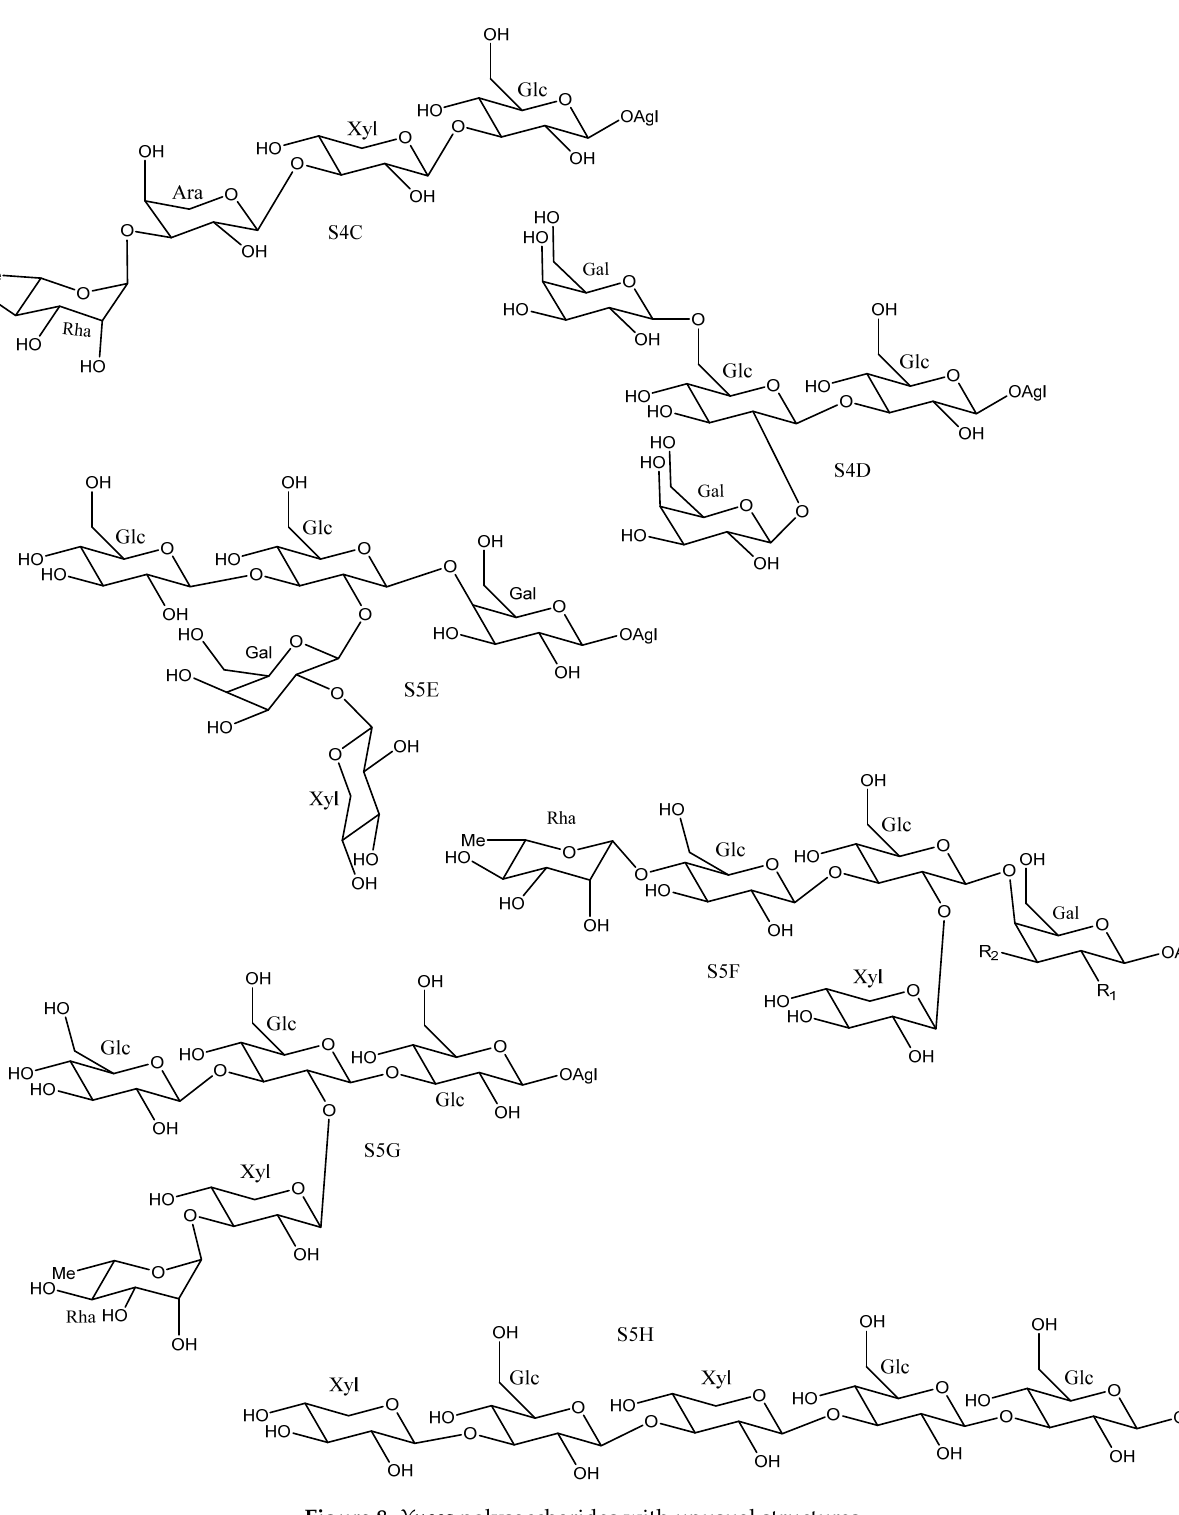
Figure 8. Yucca polysaccharides with unusual structures.